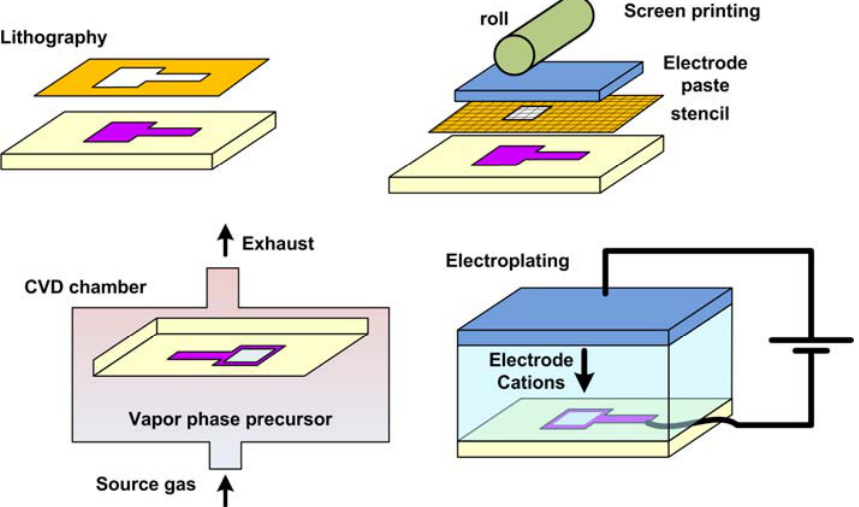
Figure 4. Different methods of micro-deposition of electrode’s